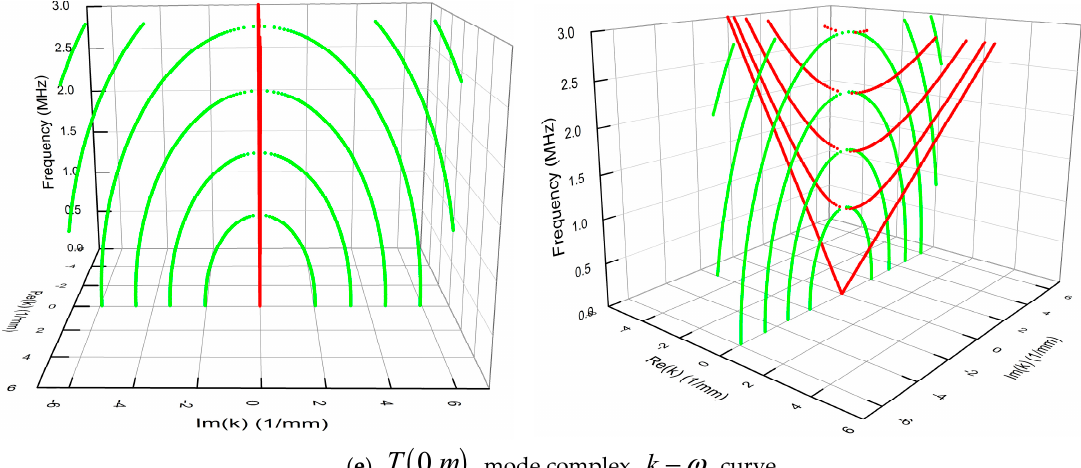
Figure 2. Complex k − ω curves for the undamped waveguide: ( a ) F ( 1, m ) mode complex k − ω curve; ( b ) F ( 2, m ) mode complex k − ω curve; ( c ) F ( 3, m ) mode complex k − ω curve; ( d ) L ( 0, m ) mode complex k − ω curve; ( e ) T ( 0, m ) mode complex k − ω curve.